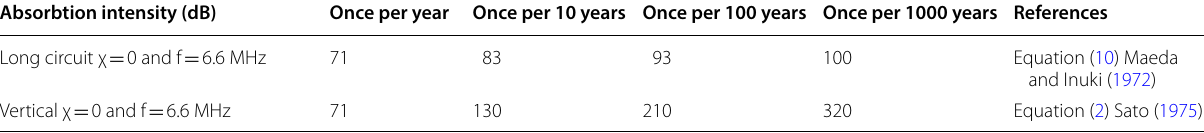
Table 3 Estimated absorbtion intensities for extreme events Absorbtion intensity